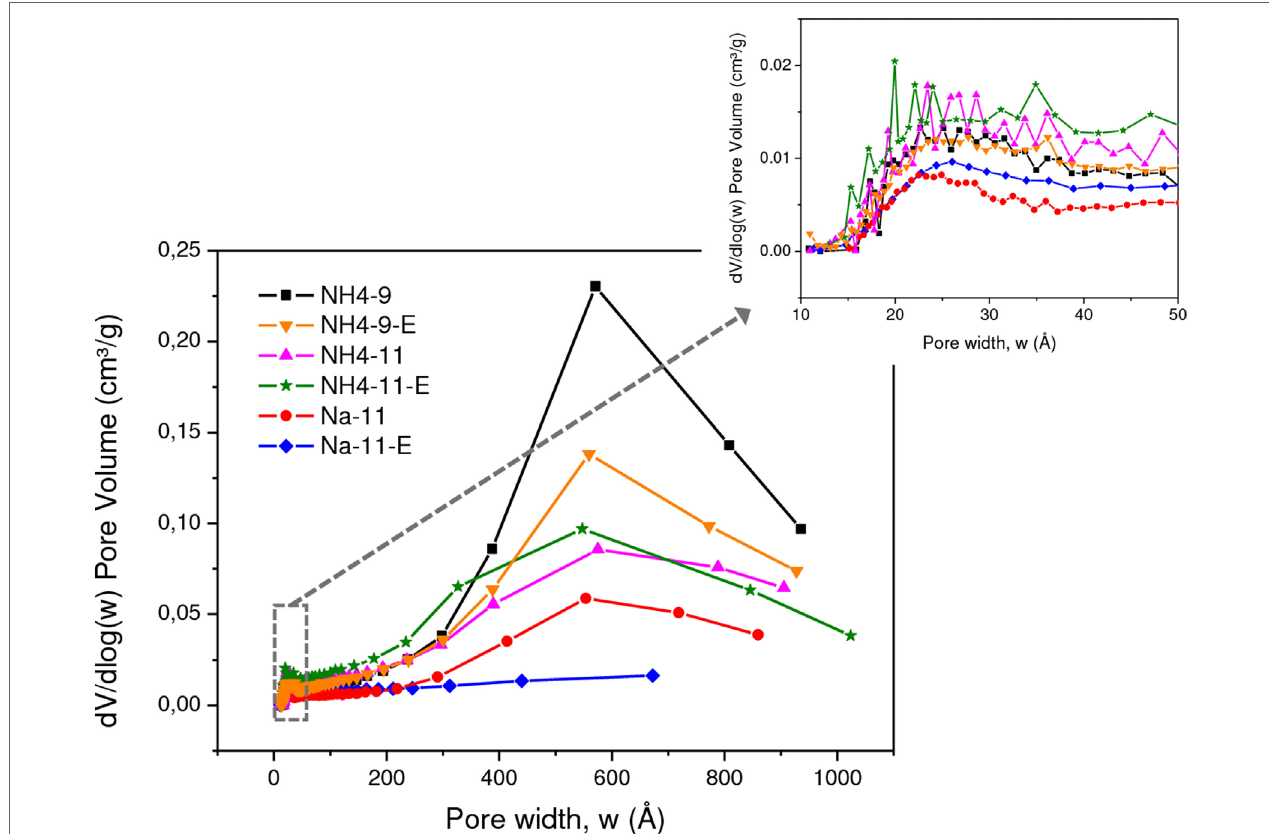
FigUre 1 | Pore size distributions of fresh calcined samples (from Barrett–Joyner–Halenda model desorption